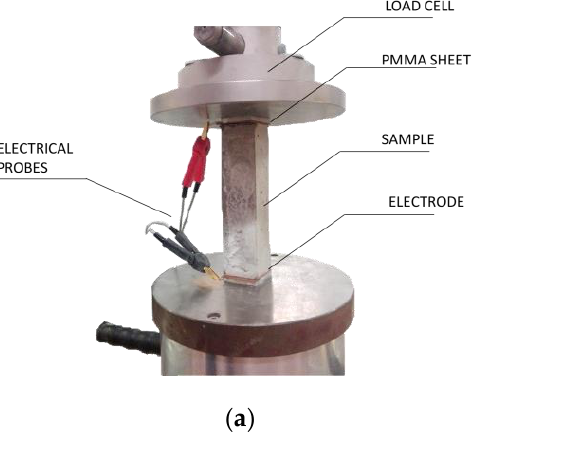
Figure 3. ( a ) General overview of the testing configuration for evaluating the stress-sensing ability of the composites, and ( b ) compression loading